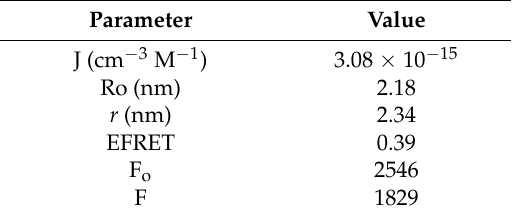
Figure 6. Overlap between the fluorescence emission spectrum of HSA and the absorption spectrum of CBH. Table 2. FRET from steady state measurements performed at 25 ◦